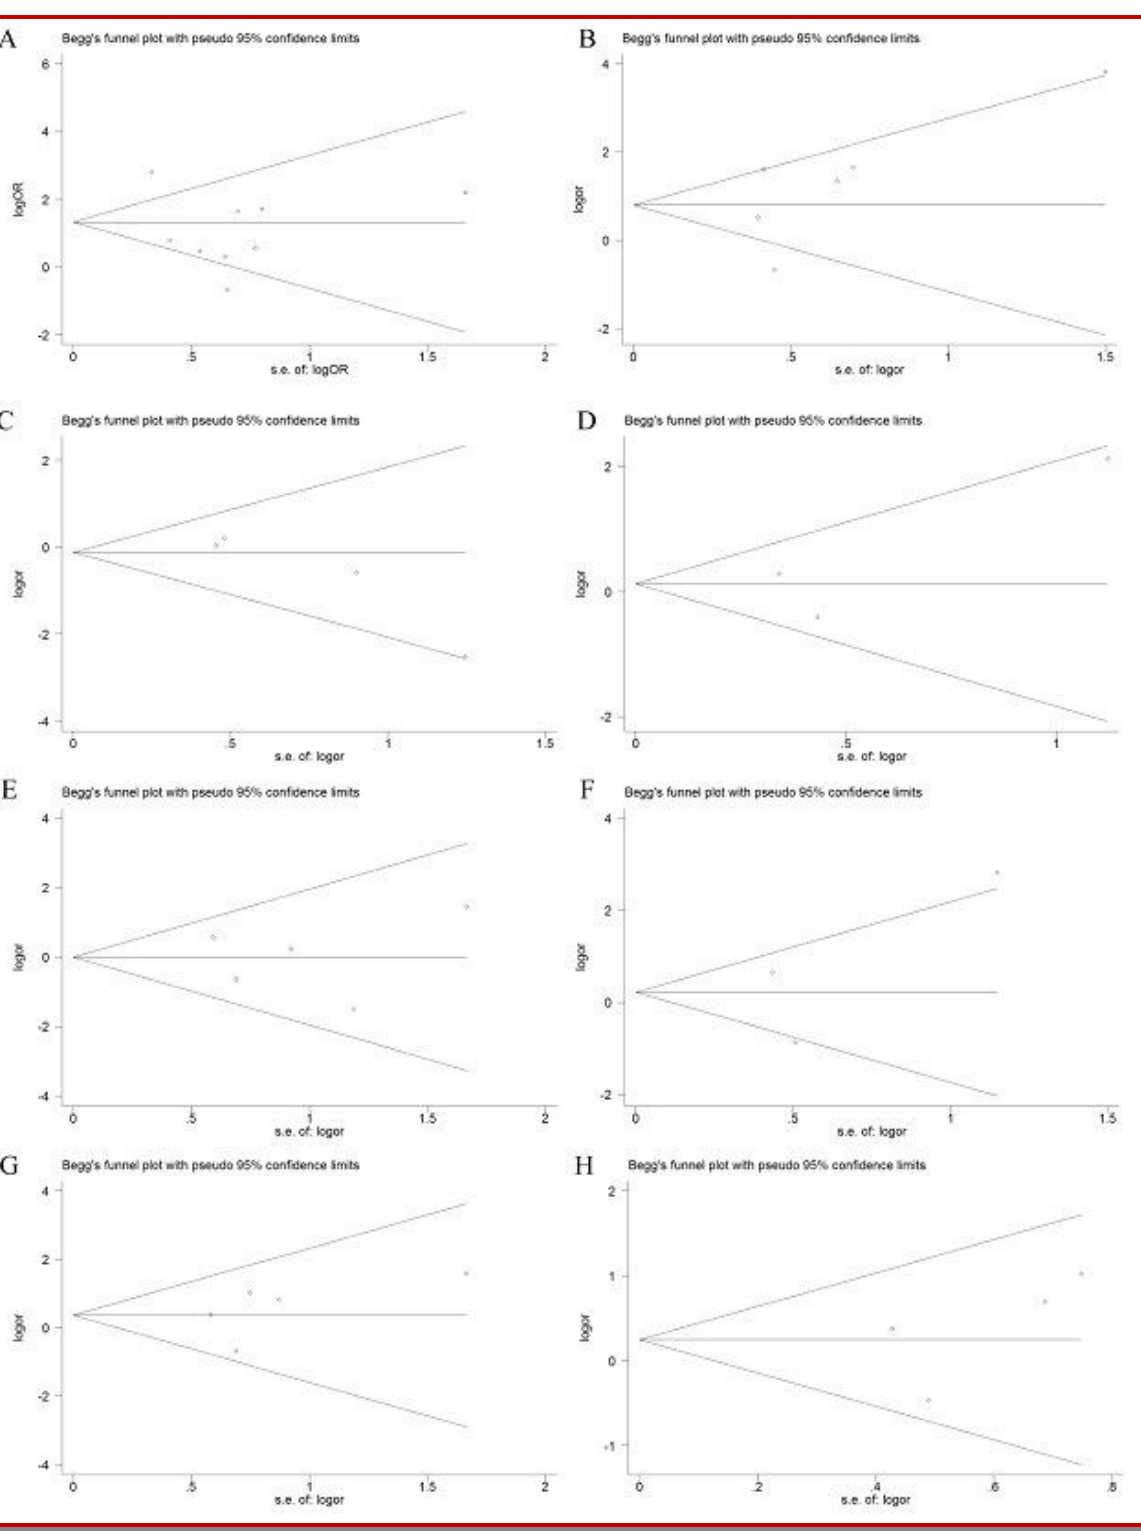
Figure 6: Funnel plot of the studies comparing the efficiency (A) 5 years-DFS of CYP2D6 Wt/Wt + Wt/*10 vs *10/*10; (B)10 years-DFS of CYP2D6 Wt/Wt + Wt/*10 vs *10/*10; (C)5 years-DFS of CYP2D6 Wt/ Wt vs Wt/*10; (D)10 years-DFS of CYP2D6 Wt/Wt vs Wt/*10; (E) 5 years-DFS of CYP2D6 Wt/Wt vs *10/*10; (F)10 years-DFS of CYP2D6 Wt/Wt vs *10/*10; (G)5 years-DFS of CYP2D6 Wt/*10 vs *10/*10; (H)10 years-DFS of CYP2D6 Wt/*10 vs